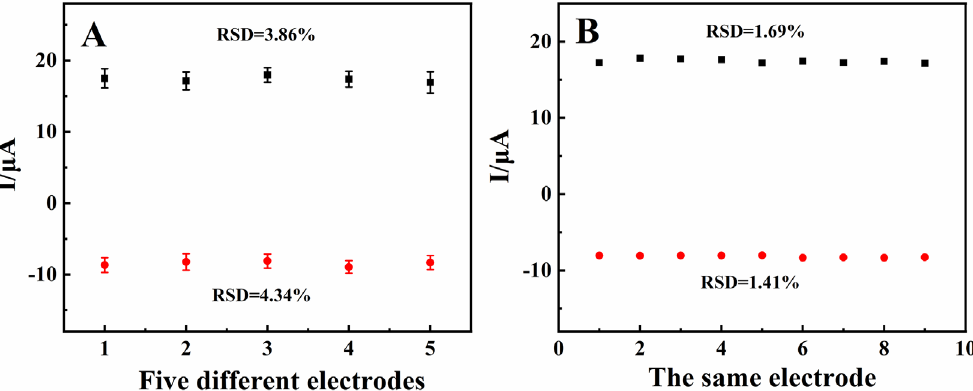
Figure 9. ( A ) Repeatability and ( B ) reproducibility of ND@BP/SPE for the detection of 0.1 mmol/L 6,7-DHC in pH 3.0 PBS at a scan rate of 100 mV/s by CV.